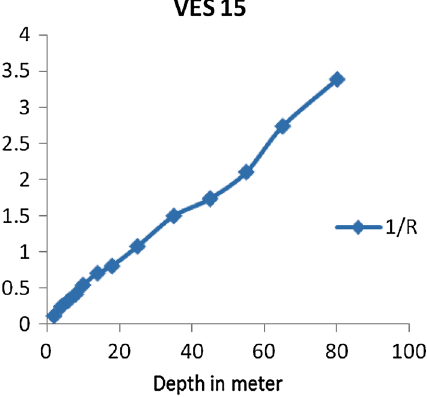
Fig. 5 Representative resistivity curve obtained by the inverse slope method from Shindkheda